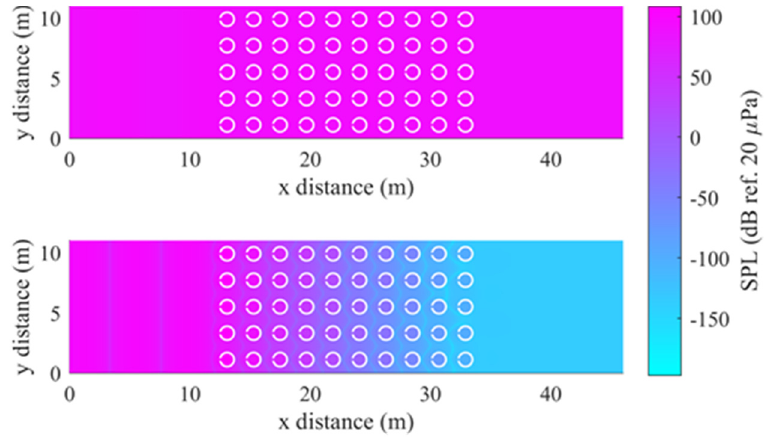
Figure 3. An FEA plot of sound pressure level of a Matryoshka locally resonant sonic crystal, modelled using COMSOL Multiphysics. Sound pressure levels are relatively consistent throughout when the incident wave has a frequency of 2 kHz ( top ) and lies outside the band gap but are attenuated considerably at 4 kHz ( bottom ) inside the gap.